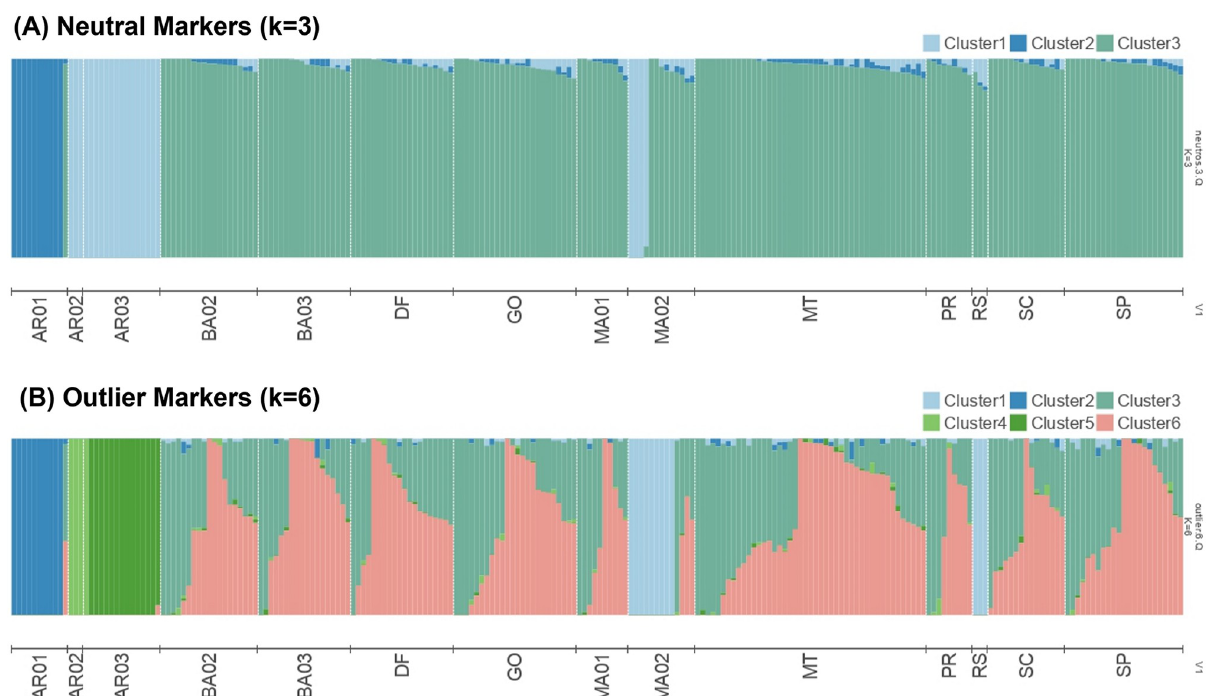
Fig 5. Admixture analysis of fall armyworm populations based on (A) 2,853 neutral SNP loci and (B) 456 outlier SNP loci. Bar plot colors indicate estimated proportions of ancestry for each individual shown as a vertical line.